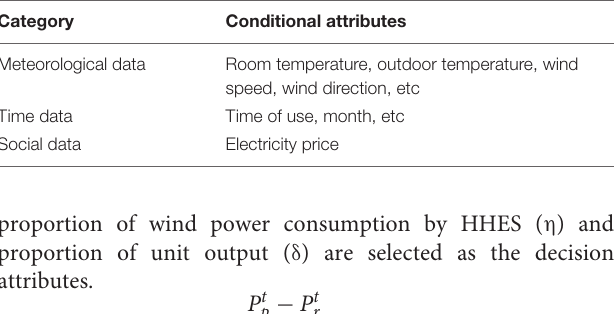
TABLE 1 | Conditional attributes of state division.